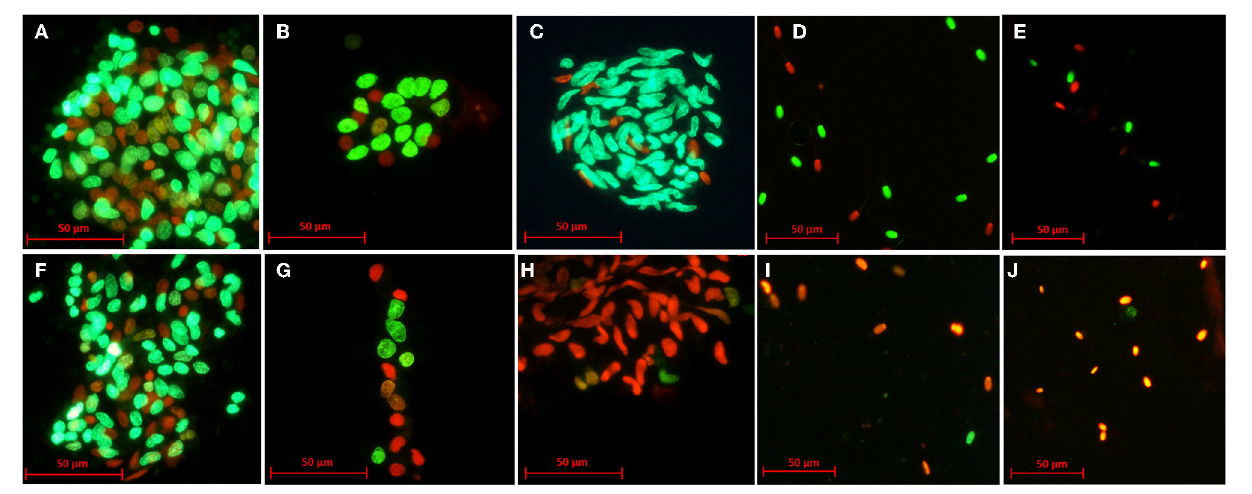
FIGURE2 Representative images of the viability of testicular cells after slow freezing-thawing (A–E) and vitrification-warming (F–J) . Green cells (SYBR-14 + ) represent live cells, while orange or red cells (PI + ) represent dead cells. Rounded germ cells from an artiodactyl (dorcas gazelle) after slow freezing-thawing and vitrification-warming (A, F) , rounded germ cells from a primate (Mandrill) after slow freezing-thawing and vitrification-warming (B, G) , elongated spermatids from a carnivore (Persian leopard) after slow freezing-thawing and vitrification-warming (C, H) , spermatozoa from an artiodactyl (European mouflon) after slow freezing-thawing and vitrification-warming (D, I) , spermatozoa from a carnivore (European mink) after slow freezing-thawing and vitrification-warming (E, J) .